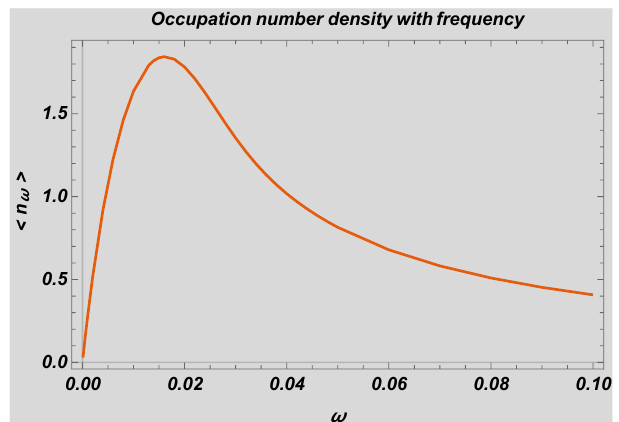
Figure 6 . Plot of particle number density versus frequency for a two dimensional set up. This figure corresponds to H = 1 and introduced a infra-red cut-off at Ω = 0 . 001